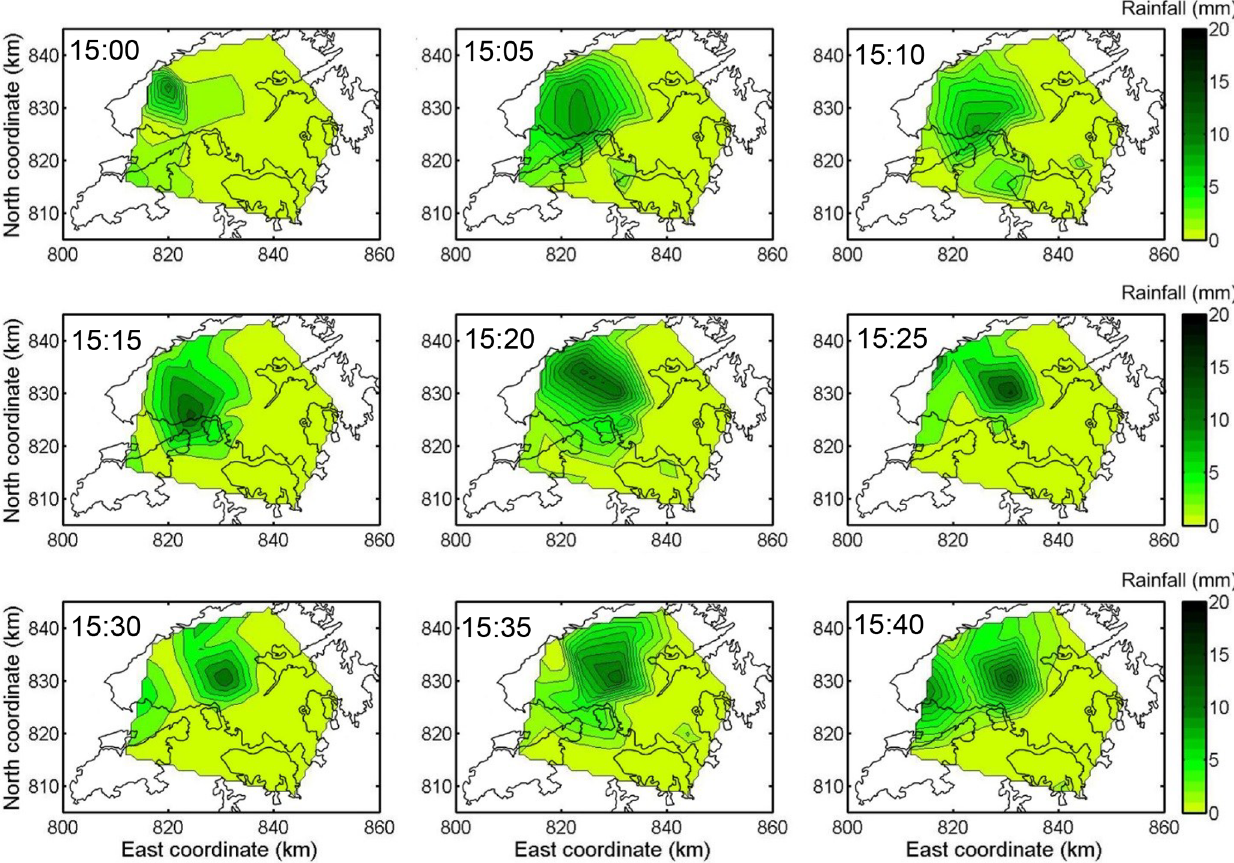
Figure 11. Instantaneous rainfall process from 15:00 to 15:40LT on 23 July 1994. Table 1. Values of maximum rolling rainfall of three landslide-triggering storms in Hong Kong.